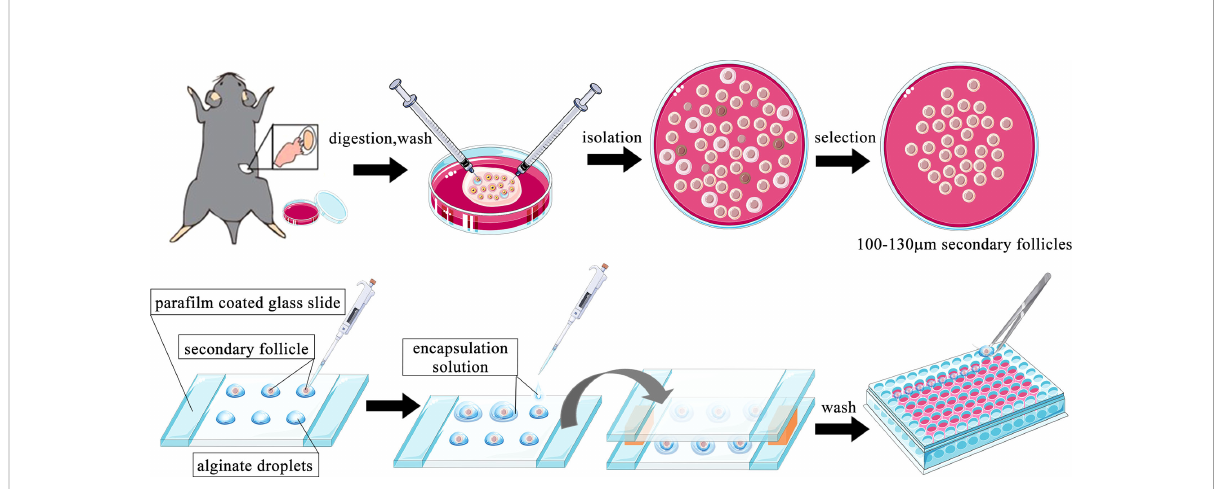
FIGURE 1 Schematic diagram of the follicle isolation and three-dimensional (3D) culture